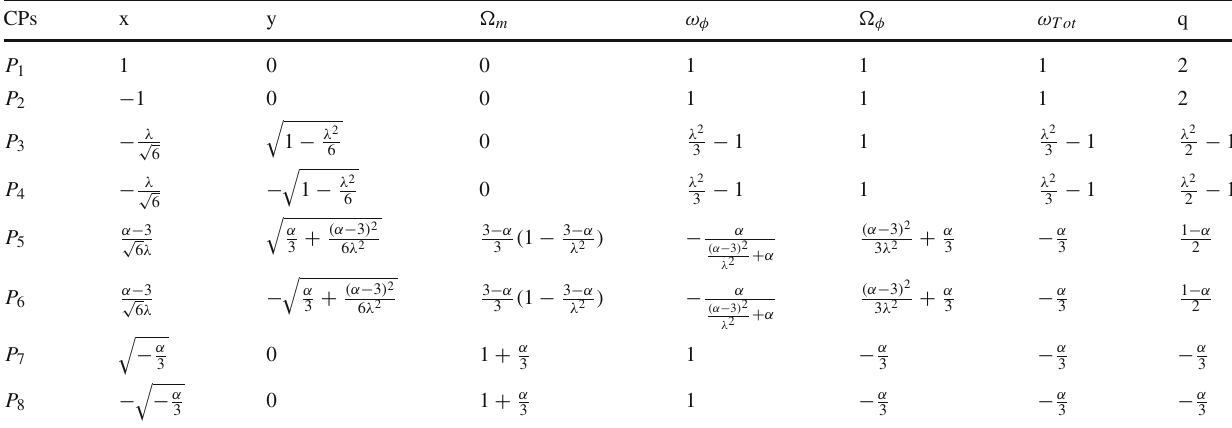
Table 1 Critical points (CPs) and corresponding cosmological parameters CPs x